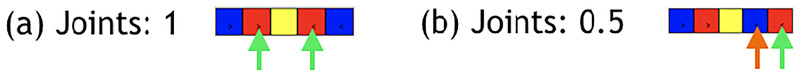
Although both morphologies have two joints, in (b) the second joint is not effective, and would be only if the module indicated by the green arrow was switched with the one indicated by the orange arrow.